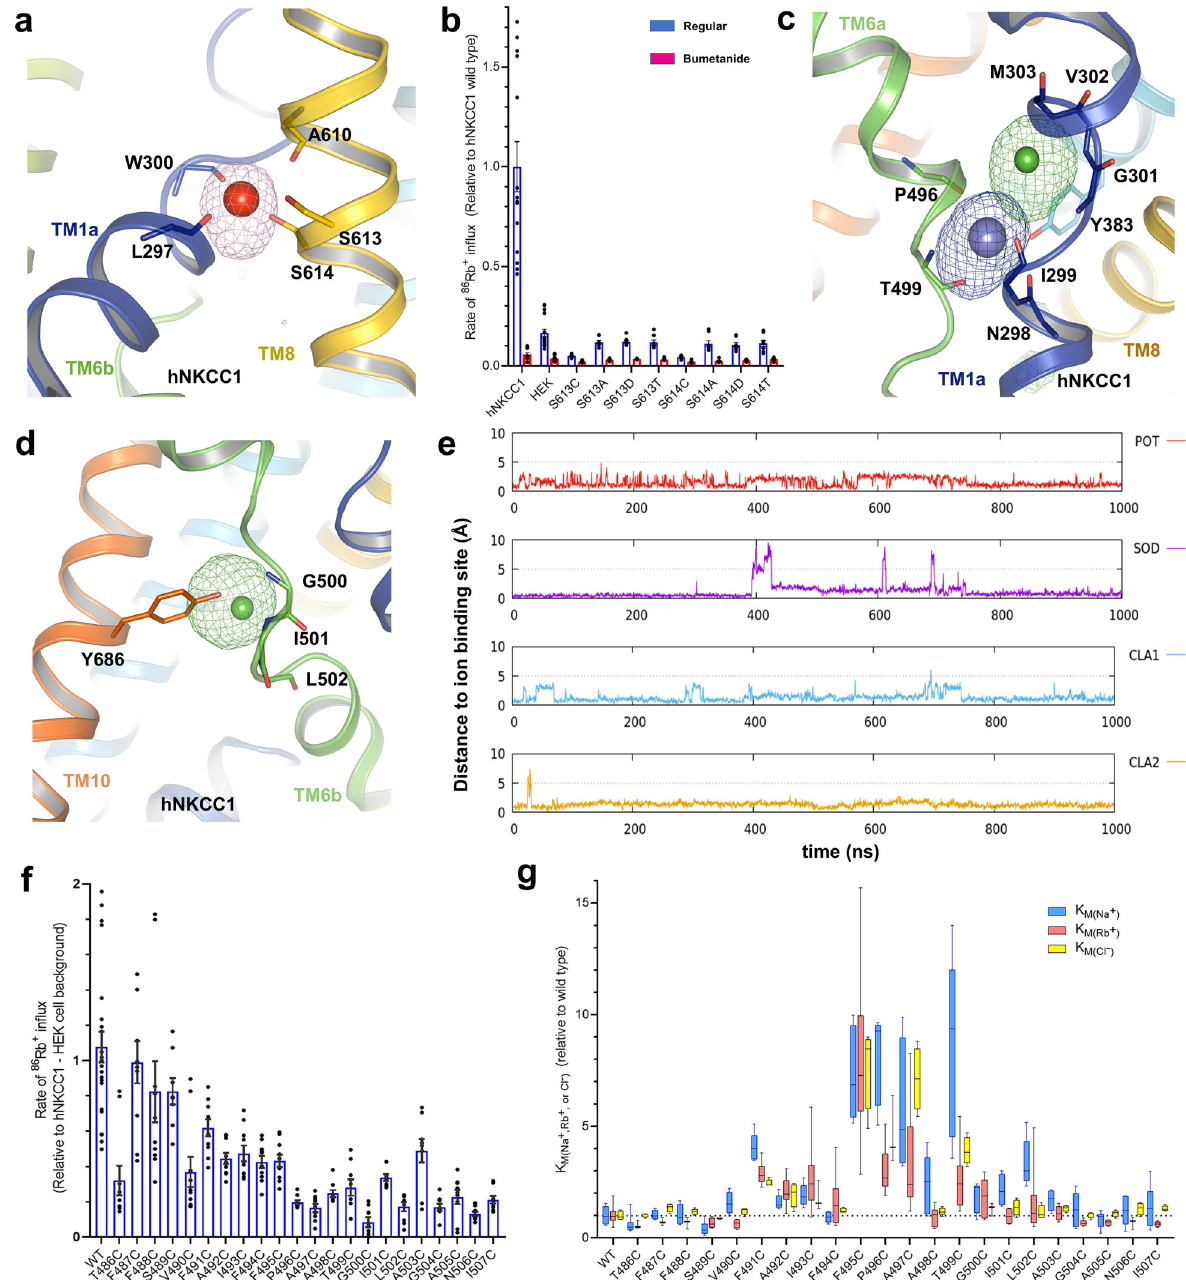
Fig. 4 Ion-binding probability densities and mutagenesis assay of hNKCC1. a The Na + binding site of hNKCC1, based on molecular dynamic simulations. Na + is stabilized by interactions with S613, S614, and A610 in TM8, and L297 and W300 in TM1. b hNKCC1 transport activity is greatly decreased by mutations of S613 and S614 in the proposed Na + -binding site; mean ± SEM. c K + and Cl − (Cl − -1) binding sites of hNKCC1 based on molecular dynamic simulations. The K + ion is stabilized by interaction with Y383 from TM3, N298, and I299 in TM1, P496, and T499 in TM6 and by the Cl − ion. The Cl − ion is stabilized by interaction with G301, V302, and M303 from TM1 and by the K + ion. d A second Cl − binding site in hNKCC1 (Cl − -2), based on molecular dynamic simulations. This Cl − ion is stabilized by interactions with G500, I501, and L502 in TM6a, and Y686 in TM10. e Time evolution of the distance of the four ions (Na + , K + , Cl − -1, and Cl − -2) from its proposed binding sites based on molecular dynamics simulation. f hNKCC1 86 Rb + transport activity of cysteine mutants in a scan of TM6; mean ± SEM. g The relative K M (for Na + , Rb + , and Cl − ) for activation of transport of each of the cysteine mutants in TM6 as a ratio to the wild-type hNKCC1. The absolute K M s of wild-type hNKCC1 were 5.6, 3.3, and 18.3 mM for Na + , Rb + , and Cl − , respectively. “ Whiskers ” indicate the maximum range of the